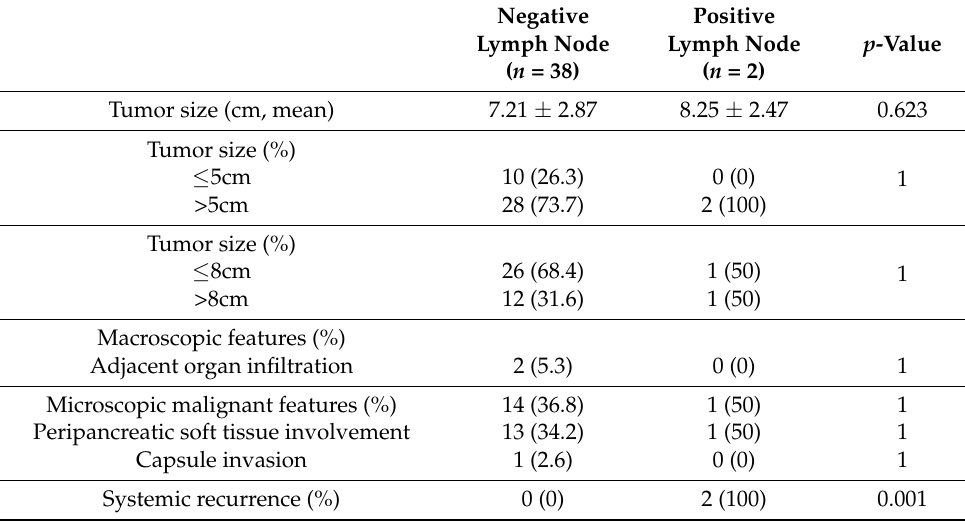
Table 3. Association between clinicopathological factors and positive lymph